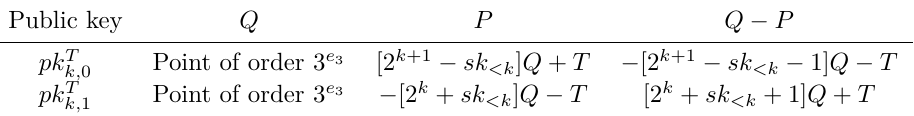
Table 2: Malicious public key points which forces the computation of